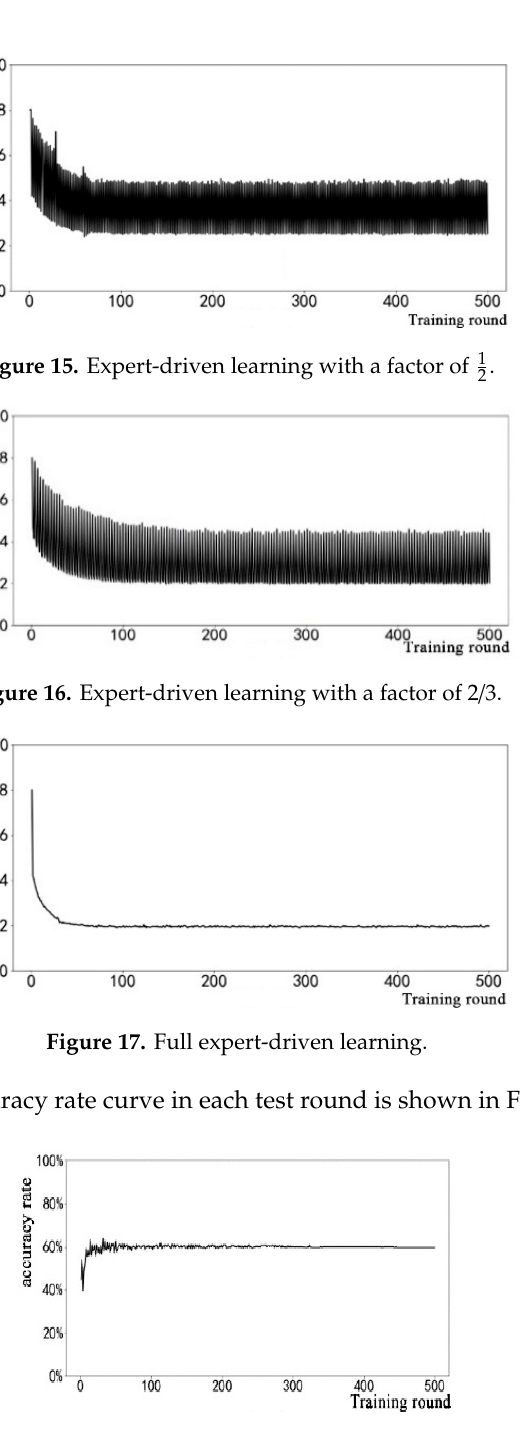
Figure 18. Expert-driven learning with a factor of 1/3.